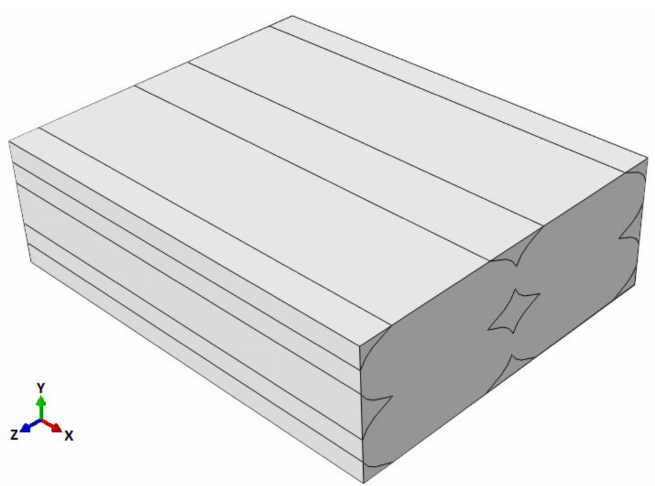
Figure 1. The representative volume element (RVE) and the reference system.